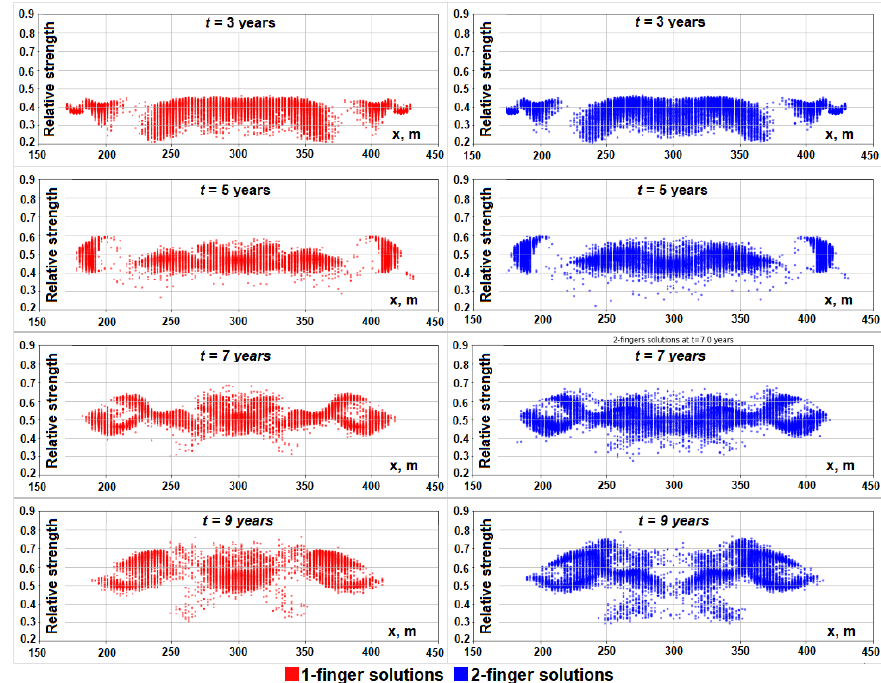
Figure 9. Distributions of fingers in the ensemble of N = 10,000 solutions at t = 3,5,7,9